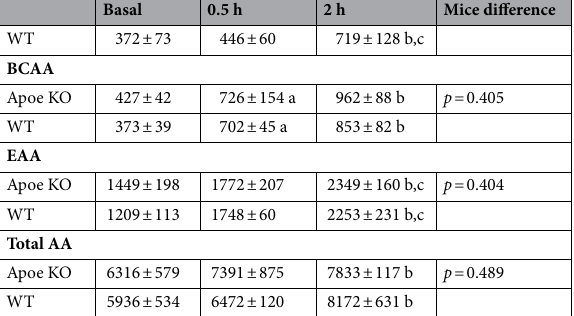
Table S1). In relation to Alpha-diversity, the number of observed species differed significantly (t-test p = 0.03) only between ApoE KO and WT at 10 weeks.